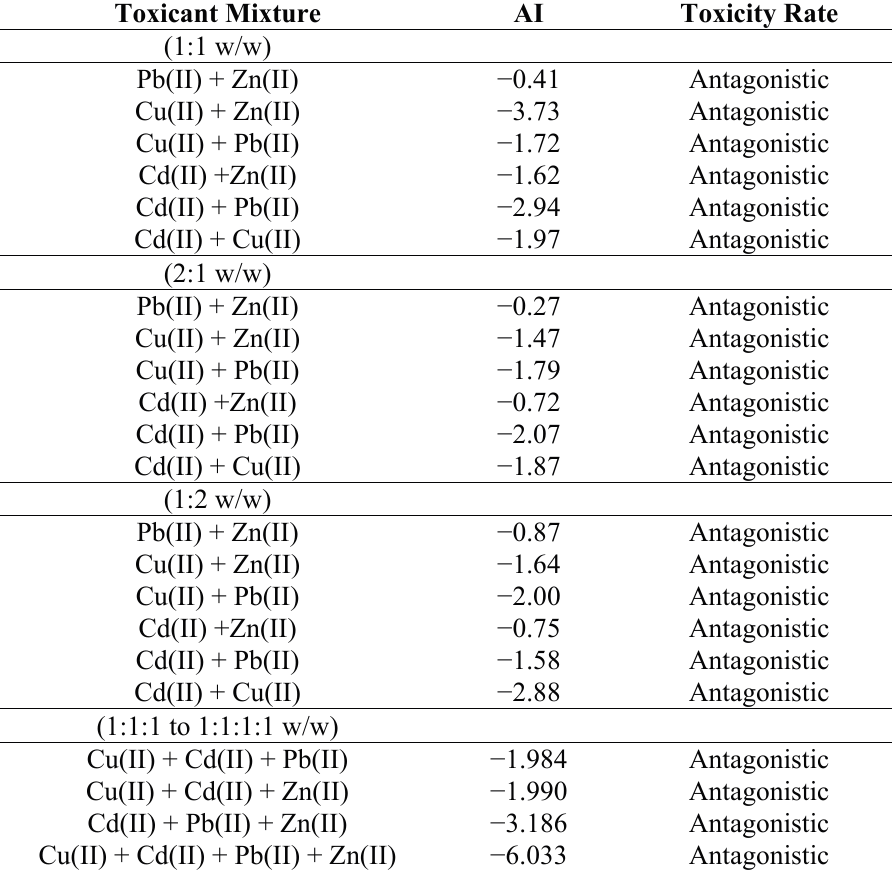
Table 4. The additive index (AI) values determined by the GFP E. coli biosensor for toxicity mixture of Cu(II), Cd(II), Pb(II) and Zn(II) at various concentration